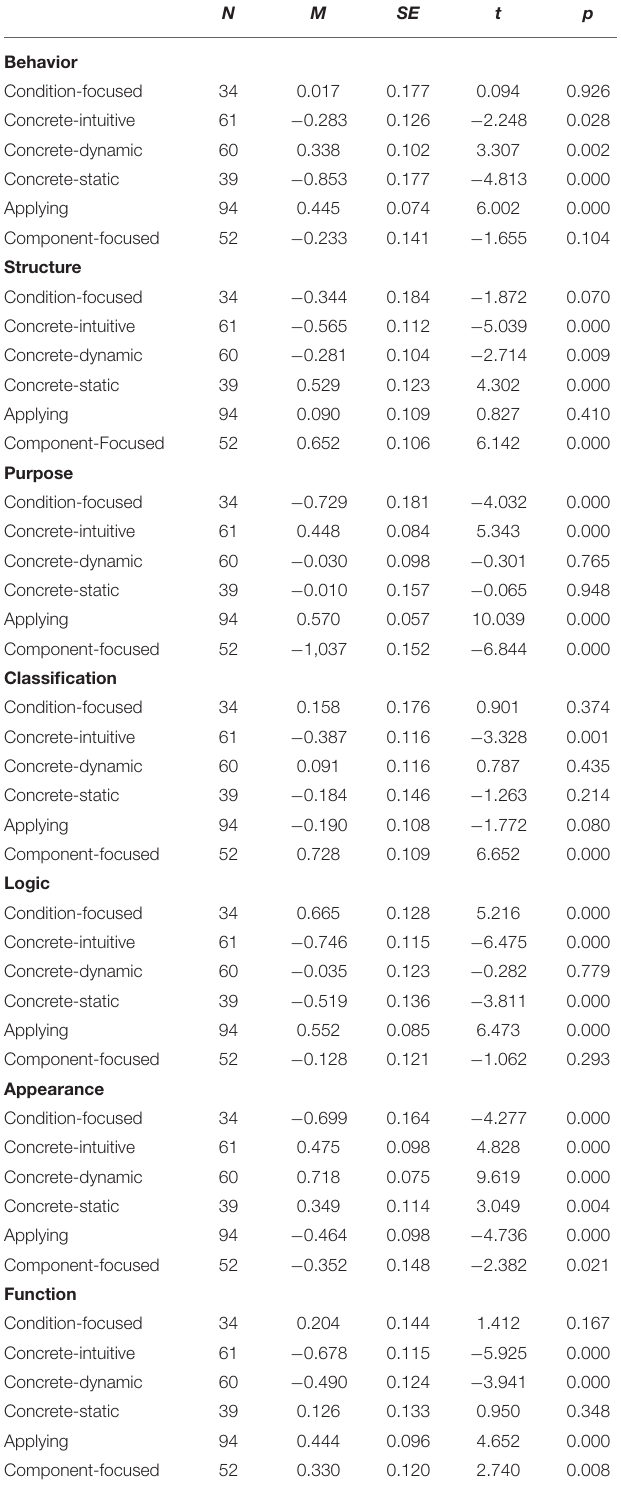
TABLE 3 | Z -standardized values and one-sample t -tests (H 0 = 0) of the ontological categories-scales in the OCET for each ontological profile used in Figure 1 .